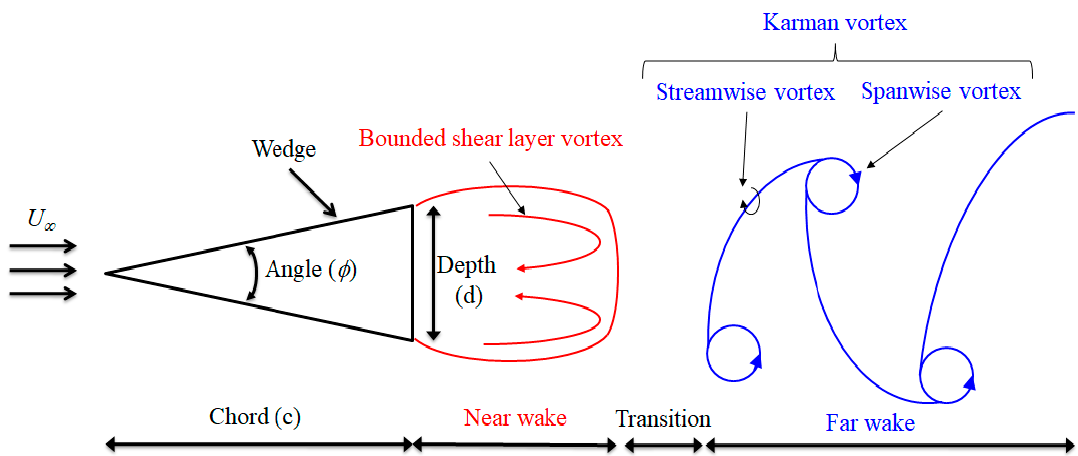
Figure 1. Problem description of cavitating flow behind wedge.